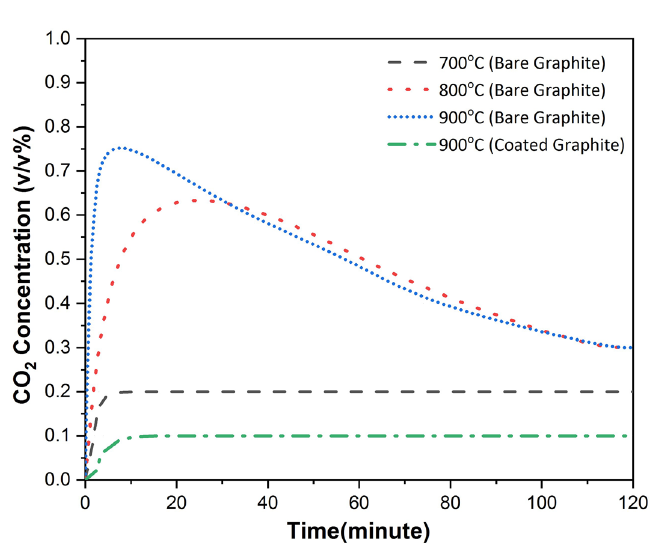
Figure 6. CO 2 generation at different temperatures for bare and Al 2 O 3 coated